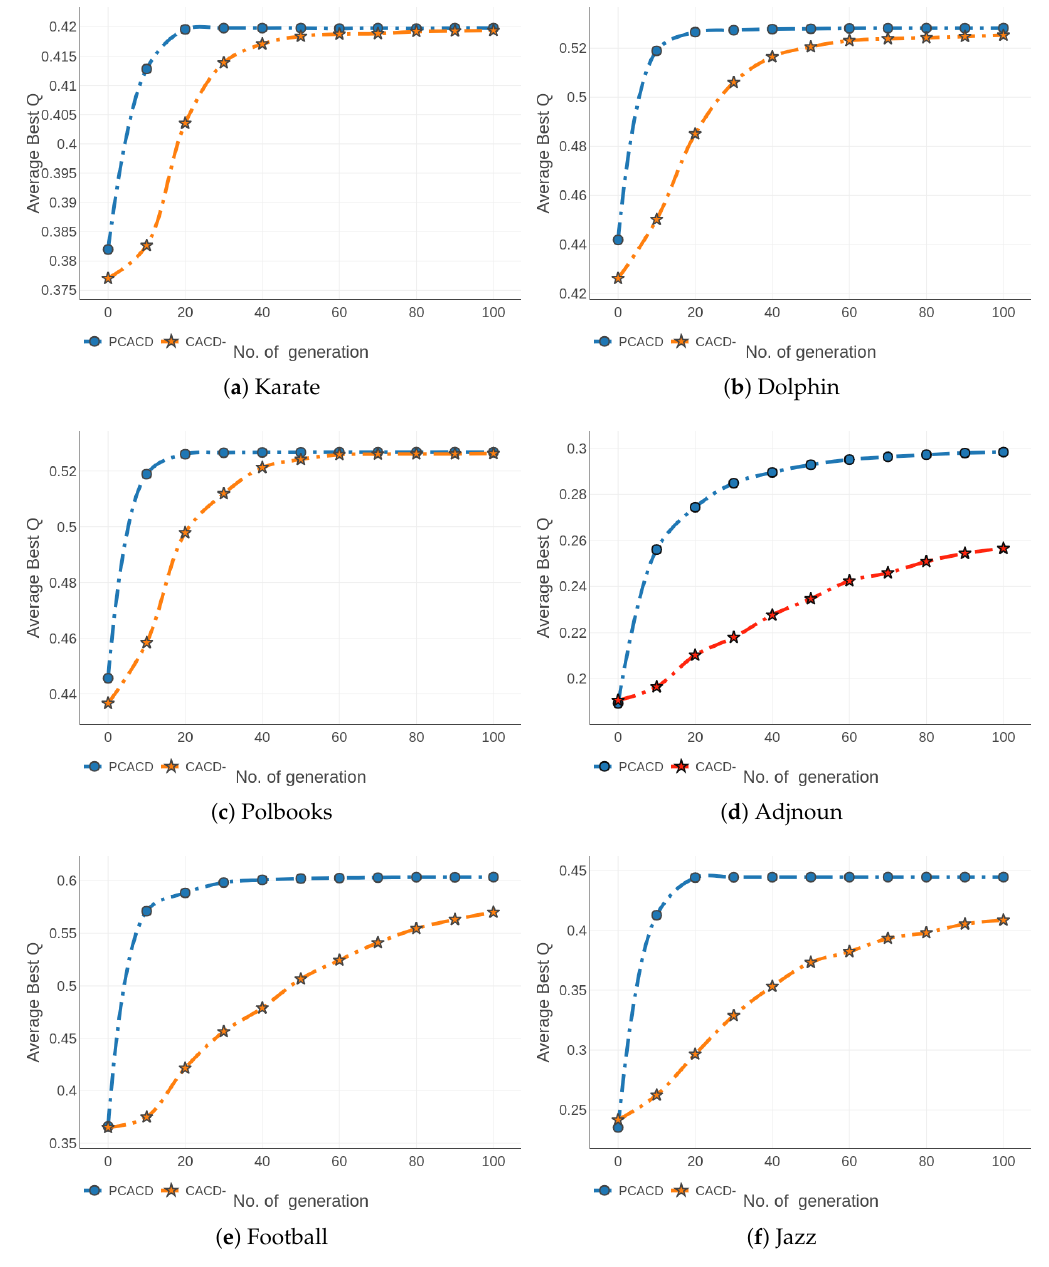
Figure 4. The convergence curve of average best Q scores over 30 runs of each of PCACD and CACD- for all six real-world